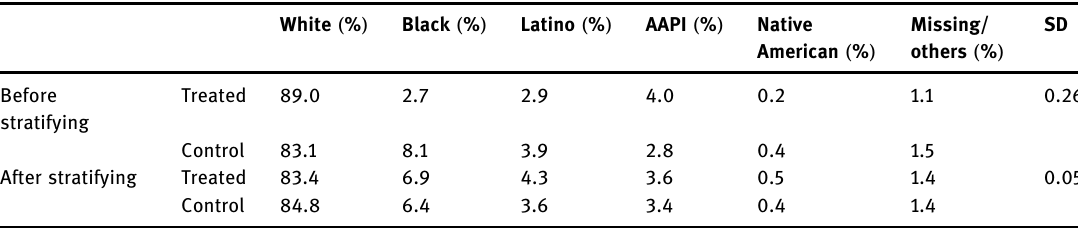
Table A2: Standardized di ff erences ( SD ) between treated and control populations in the observational database, before and after strati fi cation on the propensity score, for ethnicity category